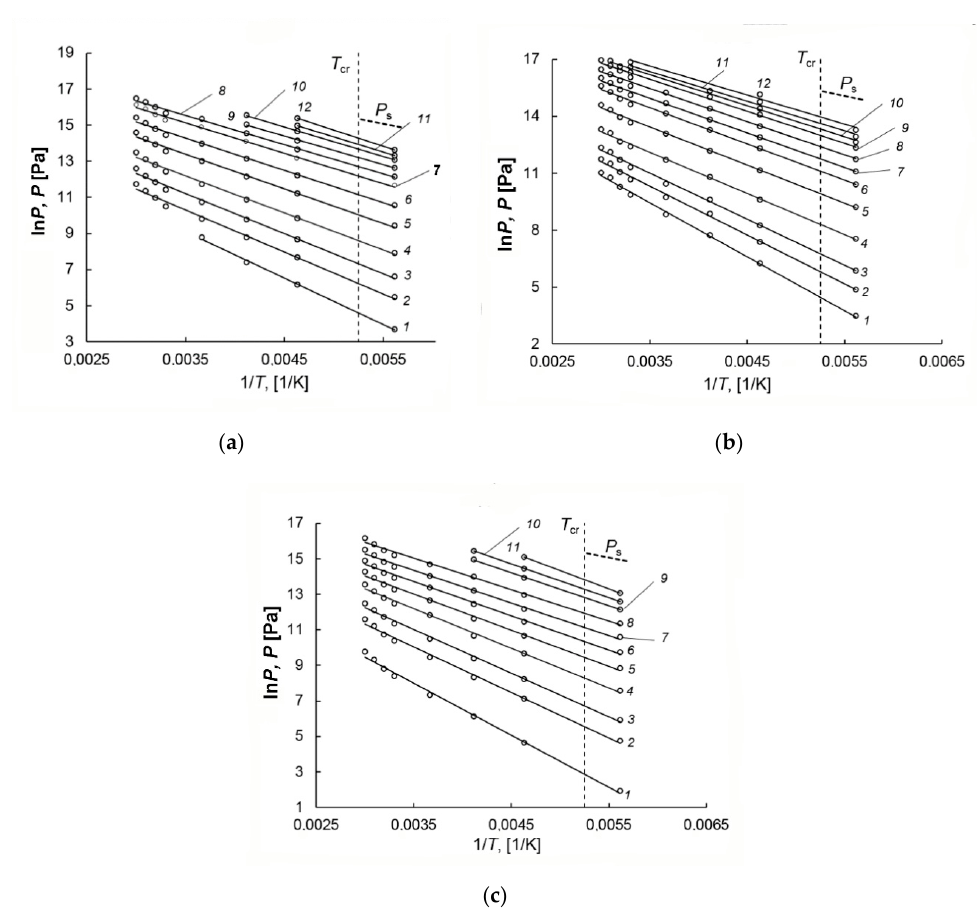
Figure 8. The isosteres of methane adsorption on: AC-90S ( a ) for the adsorption value a (mmol / g) of 0.2 (1), 0.5 (2), 1.0 (3), 2.0 (4), 4.0 (5), 6.0 (6), 8.0 (7), 9.0 (8), 10.0(9), 11.0(10), 11.5 (11), 12.2 (12); AC-90L ( b ) for a (mmol / g) of 0.3 (1), 0.6 (2), 1.0 (3), 2.0 (4), 4.0 (5), 6.0 (6), 7.0 (7), 8.0 (8), 9.0 (9), 9.5 (10), 10.0 (11), 10.5 (12); AC-60L ( c ) for a (mmol / g) of 0.1 (1), 0.5 (2), 1.0 (3), 2.0 (4), 3.0 (5), 4.0 (6), 5.0 (7), 6.0 (8), 7.0 (9), 7.5 (10), 8.0